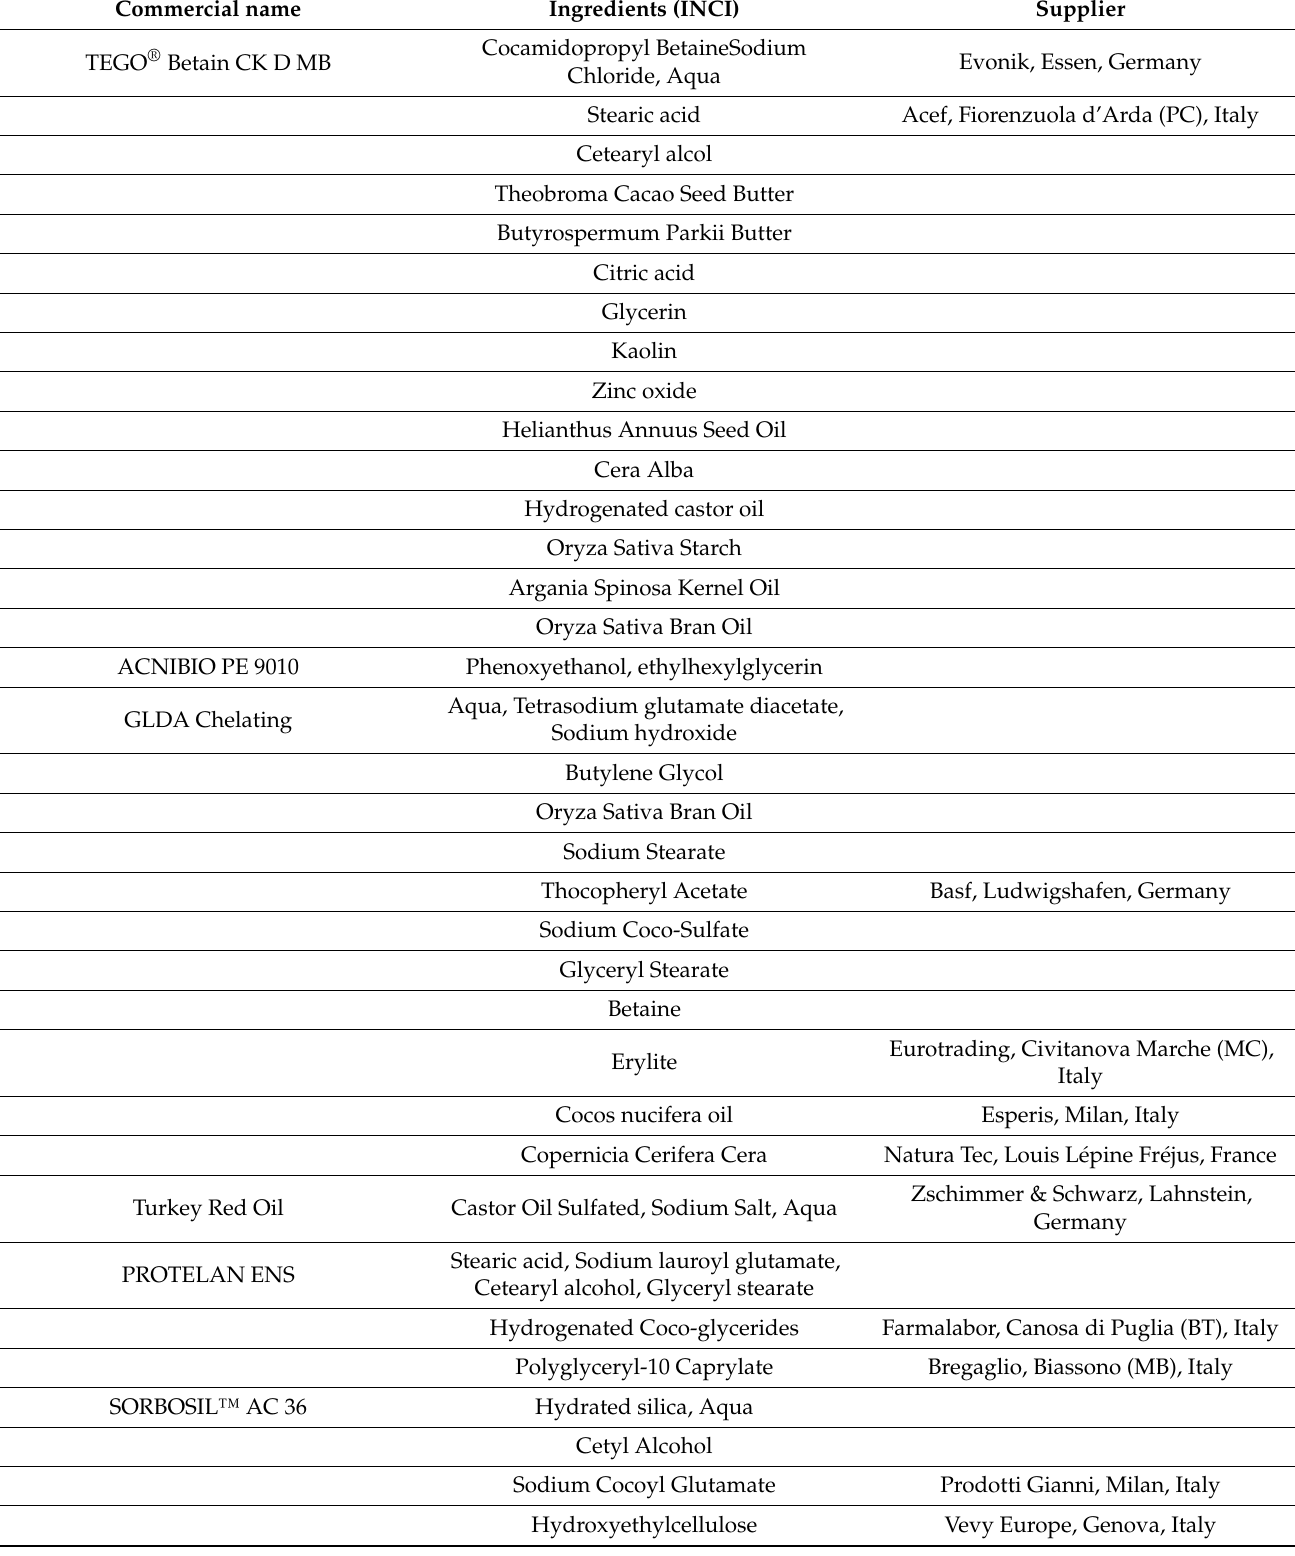
Table 3. Ingredients used in the formulation of cosmetic products, their function and the supplier.